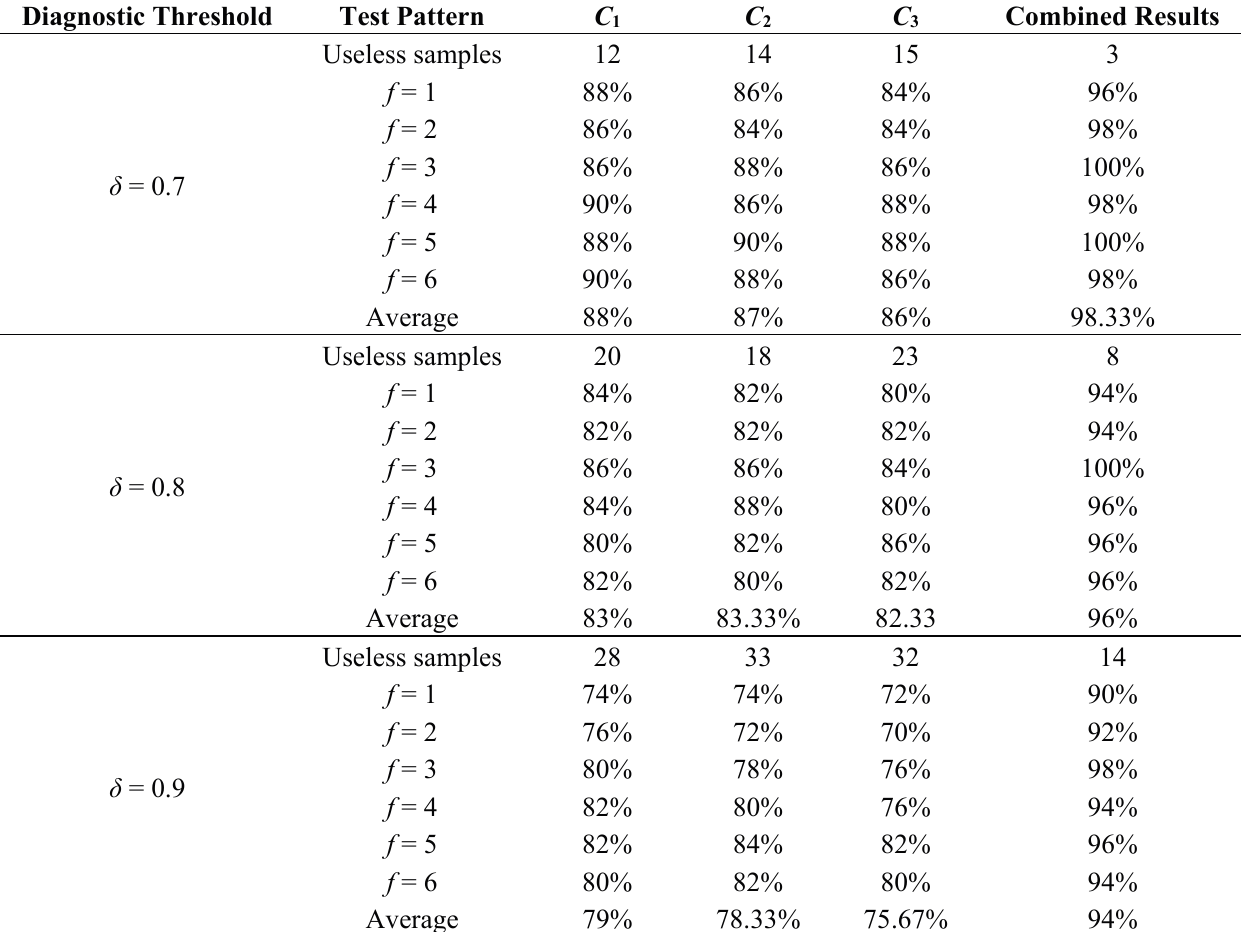
Table 7. Comparison of classification results based on different classifiers with different δ